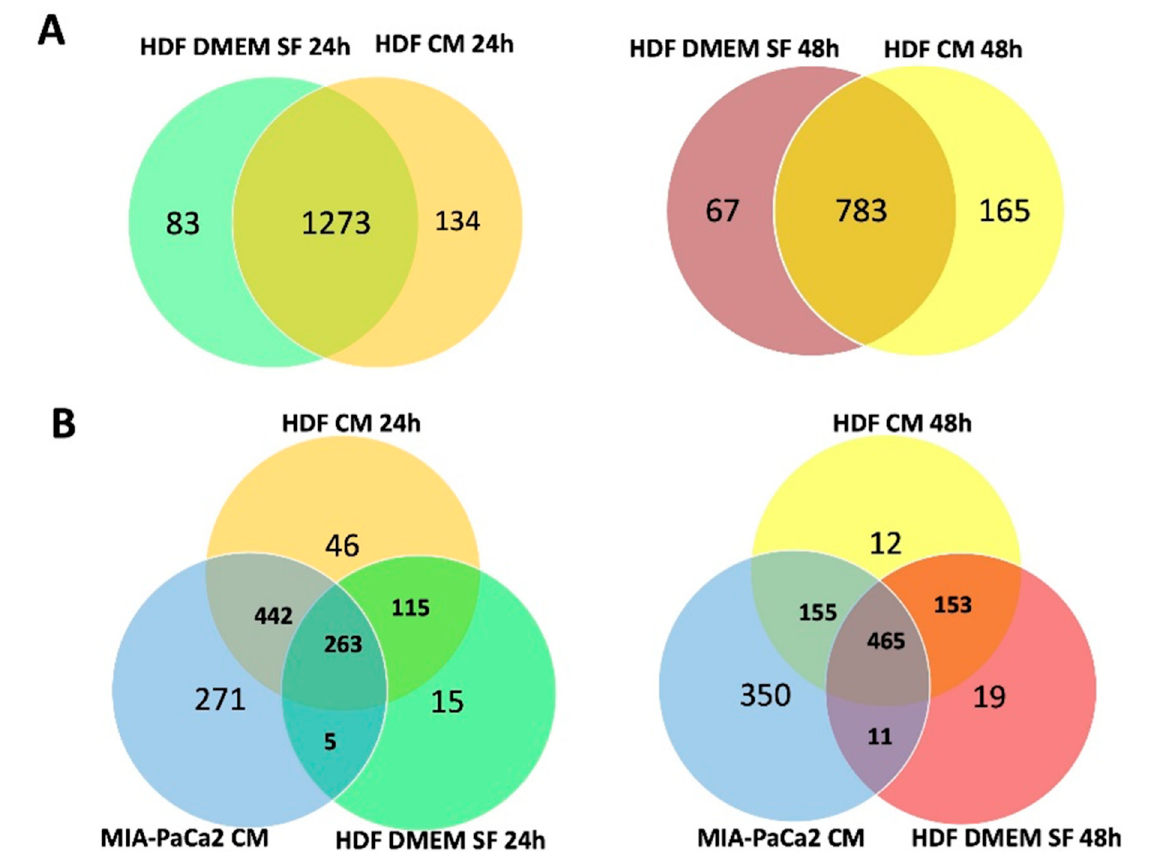
Figure 2. Proteins identified in HDF cell lysates and supernatants. ( A ) Venn diagrams showing the number of proteins detected in HDF total cell lysates treated (HDF CM) or not (HDF DMEM SF) with MIA-PaCa2 CM for 24 h and 48 h. Proteins in common between treated and untreated samples are indicated by the overlapping circles. ( B ) Venn diagrams showing the number of proteins detected in HDF supernatants treated (HDF CM) or not (HDF DMEM SF) with MIA-PaCa2 CM for 24 h and 48 h. Proteins in common between samples are indicated by the overlapping circles.